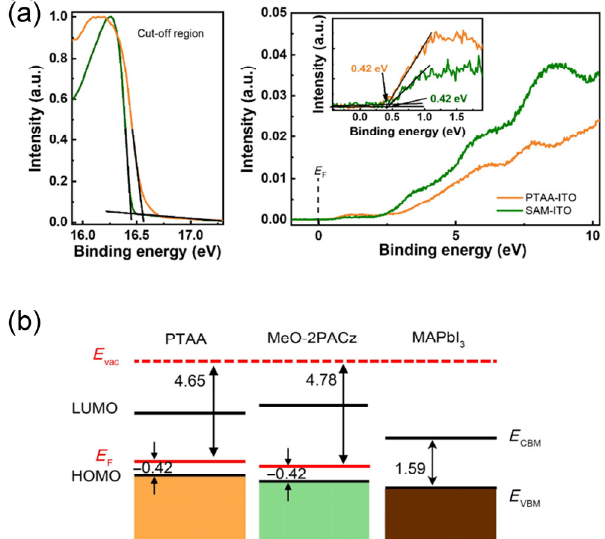
Figure 3 The contac t angles of (a) PTAA-based substrate and (b) SAM- based substrate. The proposed perovskite nucleation and growth mechanisms after blade-coating and during thermal annealing on (c) PTAA-based substrate and (d) SAM-based